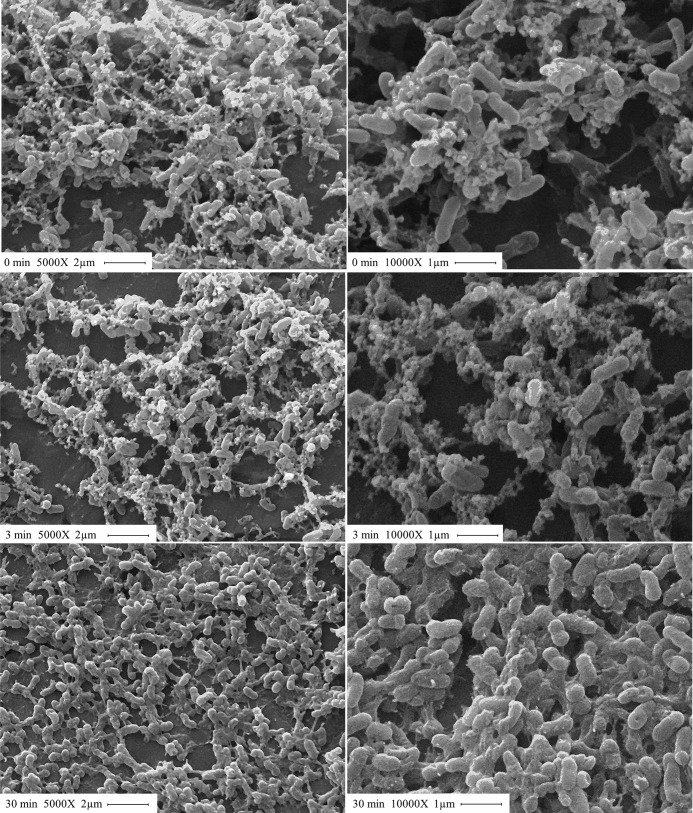
SEM images of plasma-treated P. aeruginosa biofilms.Biofilms were treated with plasma for 0, 3, and 30 min (from top to bottom). Magnification: 5000X and 10000X for images on the left and right panels, respectively.